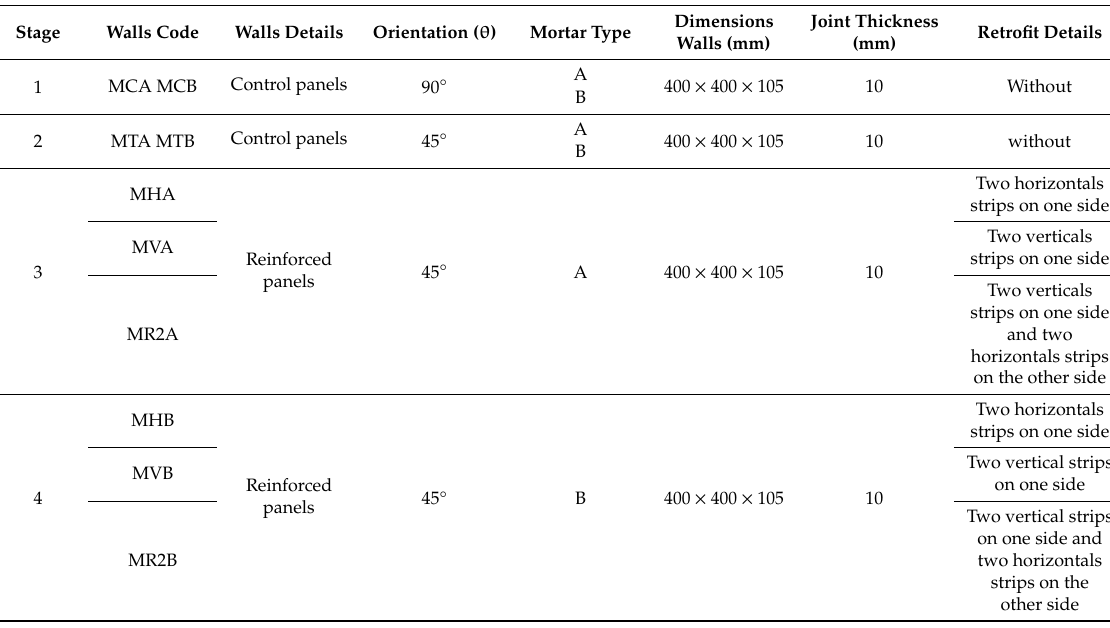
Table 3. Walls dimensions and CFRP retrofit details.